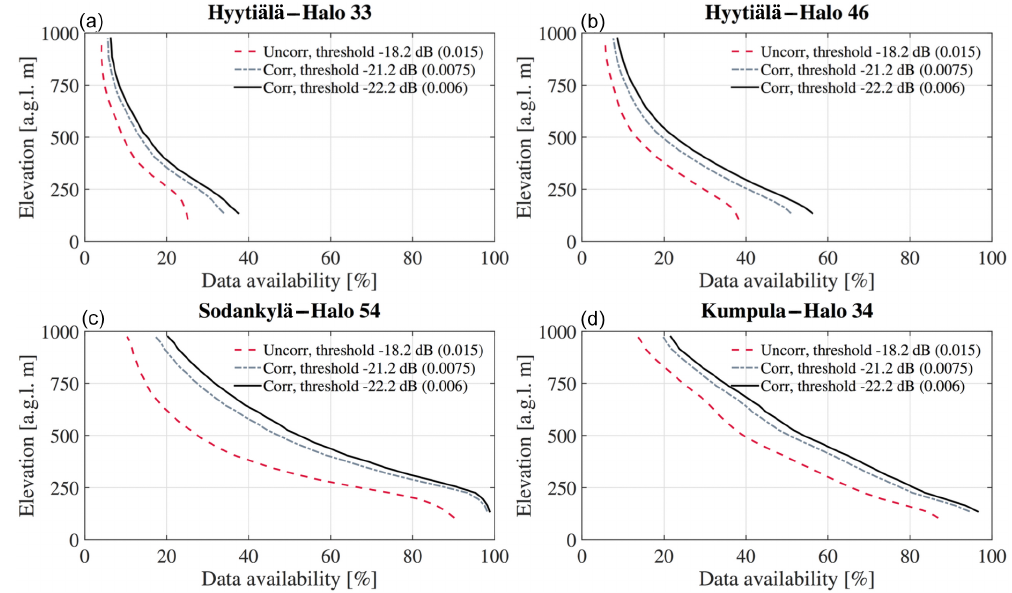
Figure 12. Data availability below 1000m, where most signals originate from aerosol, for different SNR thresholds: ( a and b , dashed red line) before, and ( a and b , dot dashed gray and black lines) after processing with the background correction algorithm. Instrument ID 33 measured from 21 May to 31 December 2014 at Hyytiälä, Finland; instrument ID 46 between 1 January 2013 and 20 April 2014 at Hyytiälä, Finland; instrument ID 54 between 1 September and 30 November 2014 at Sodankylä, Finland; instrument ID 34 between 1 January and 31 March 2014 at Kumpula in Helsinki, Finland.